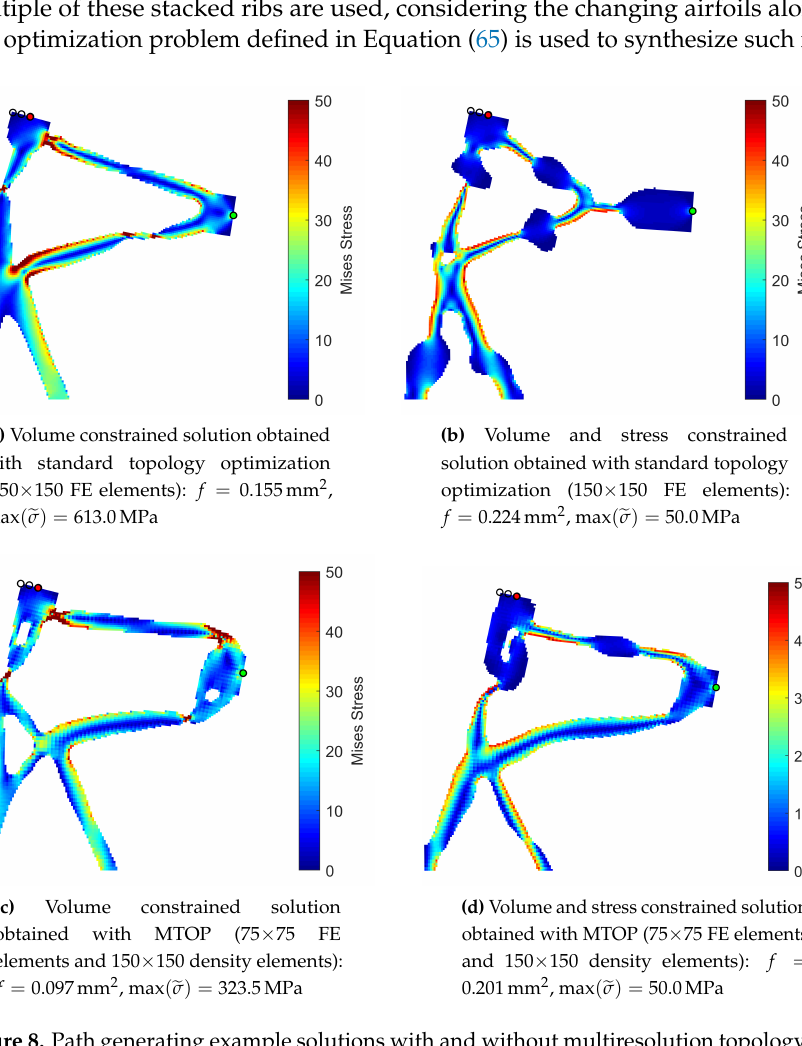
Figure 7. Path generating example mechanism topology with smoothed boundary based on Figure 6